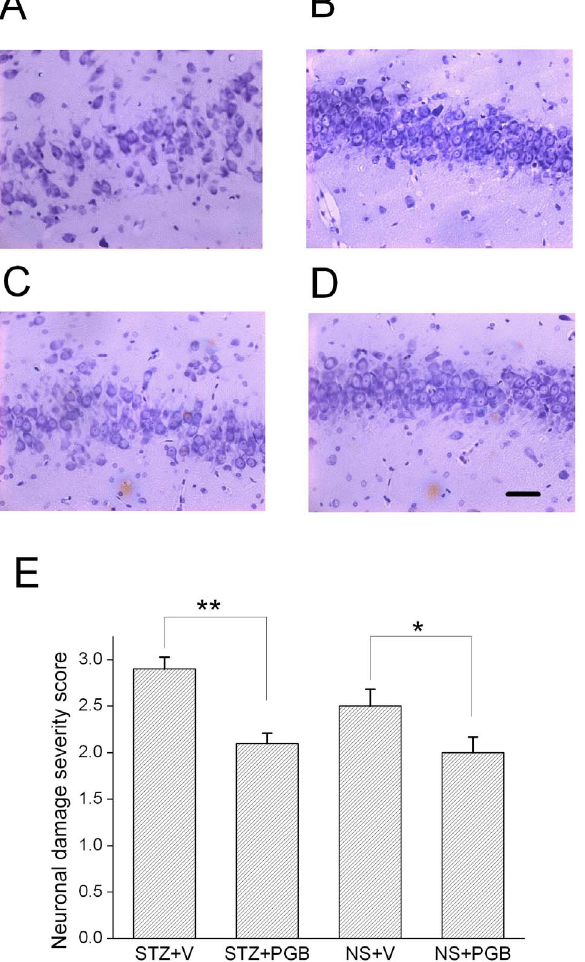
Figure 3. Neuronal loss during the post-status epilepticus acute stage. Twenty-four hours after status epilepticus, cresyl violet staining showed substantially fewer neurons in the hippocampal CA3 area in A, the STZ + V group, than in B, the STZ + PGB group. There was more neuronal death in the hippocampal CA3 area in C, the NS + V group, than in D, the NS + PGB group. A semi-quantitative analysis, E , showed that the difference between the CA3 areas was significant (STZ + V versus STZ + PGB, p , 0.01; NS + V versus NS + PGB, p , 0.05) (Kruskal-Wallis H test and then Dunn’s multiple comparison test, n=5 in each group, ** p , 0.01; * p , 0.05). The scale bar ( D ) represents 40 m M.